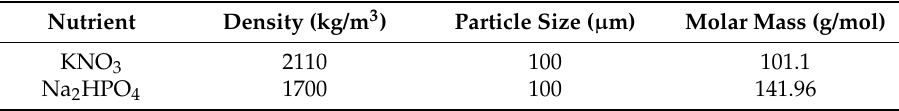
Table 1. Properties of different chemical compounds used in this